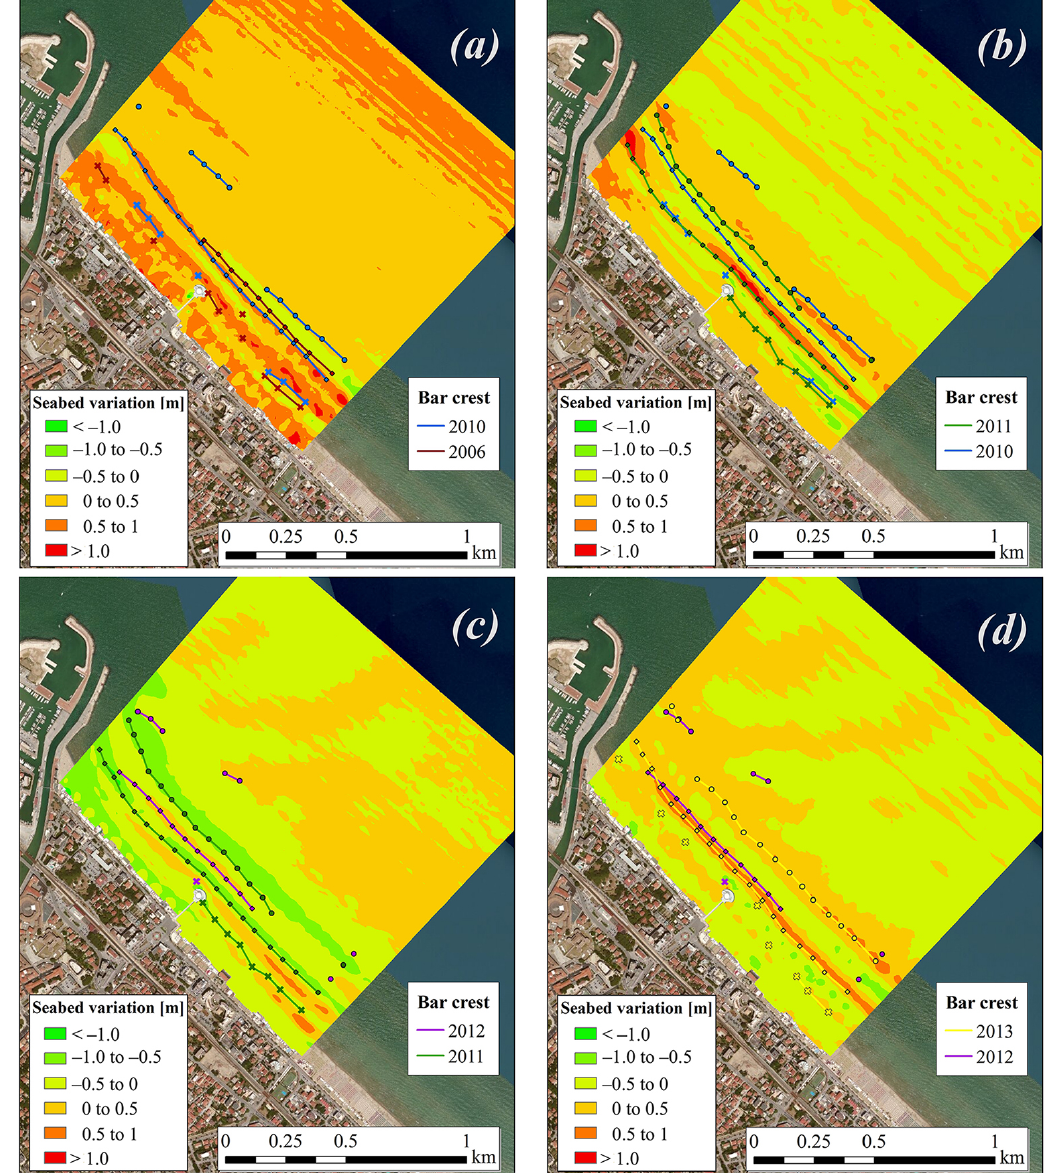
Figure 4. Sea bottom variation within time periods: (a) 2006–2010, (b) 2010–2011, (c) 2011–2012 and (d) 2012–2013. The bar-crest locations extracted from the cross-shore profiles are represented using colored lines and symbols ( + : inner, (cid:3) : intermediate, ◦ :